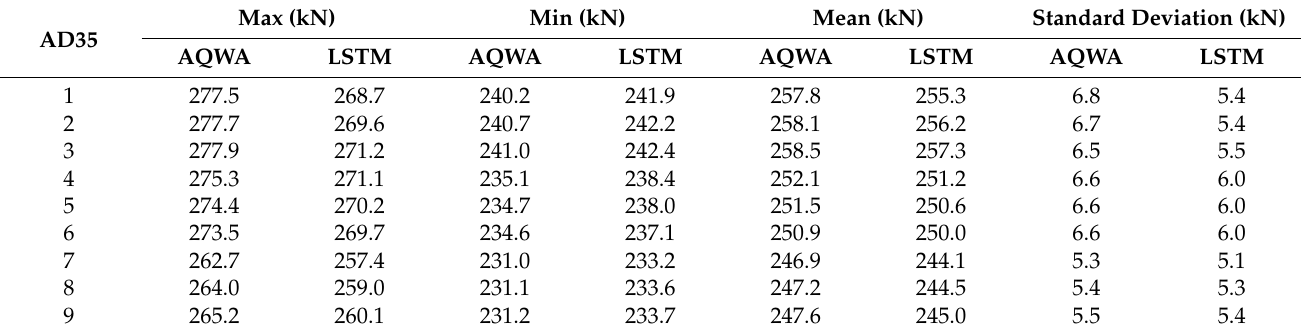
Table 15. Result statistics of AD35.